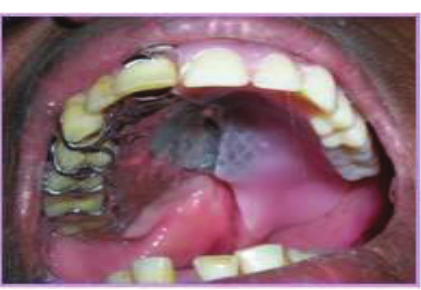
Figure 1: Maxillectomy defect.